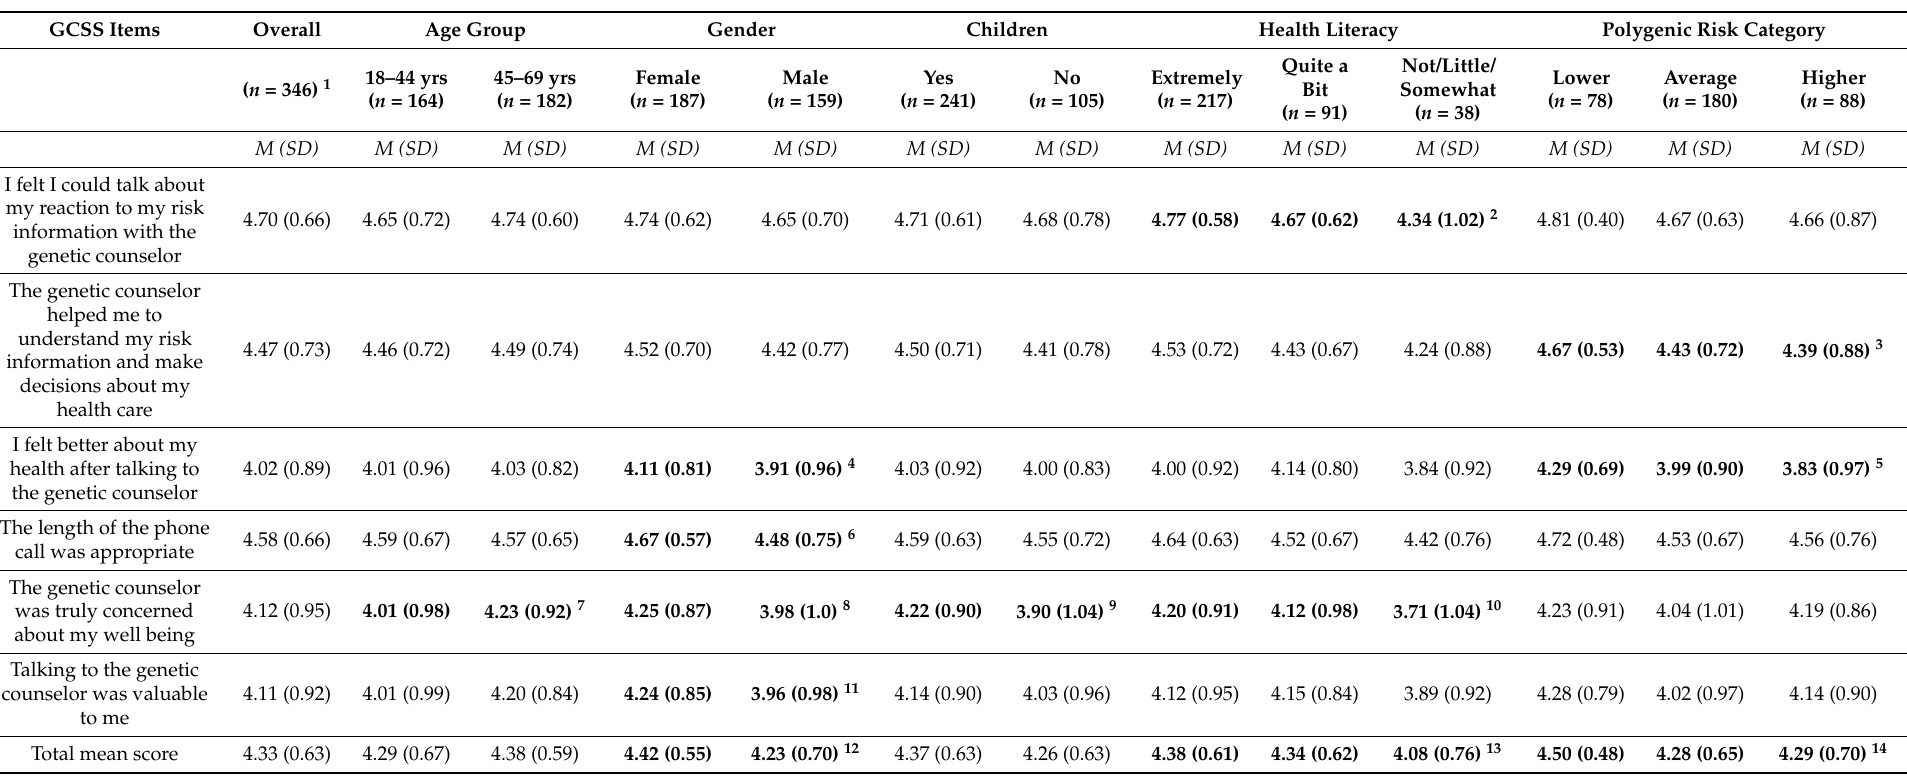
Table 2. Genetic Counseling Satisfaction Survey (GCSS) mean scores overall and within